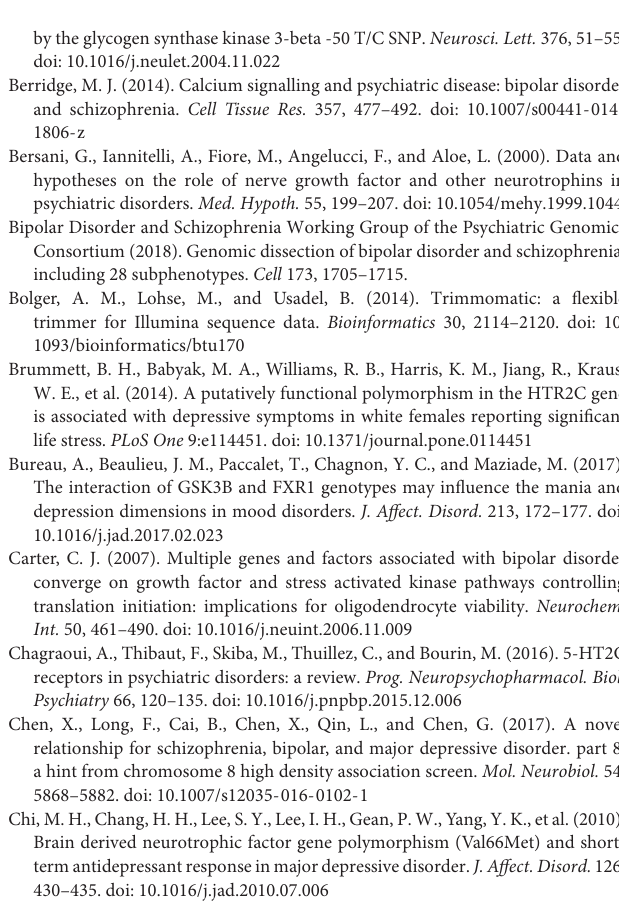
FIGURE S1 | Shown are molecular interactions as predicted by String. (A) A network limited only to input proteins. In evidence mode in String, an edge is drawn with differently colored lines that represent the existence of various types of evidence used in predicting the associations. Blue line – cooccurrence evidence, purple line – experimental evidence, yellow line – textmining evidence (i.e., the two proteins are co-mentioned in PubMed abstracts), light blue line – database evidence, and black line – coexpression evidence. (B) The same network expanded with additional top 20 predicted functional partners within the first shell of interactions (a direct connection with the input proteins). In confidence mode in String the thickness of the line indicate the degree of confidence prediction of the